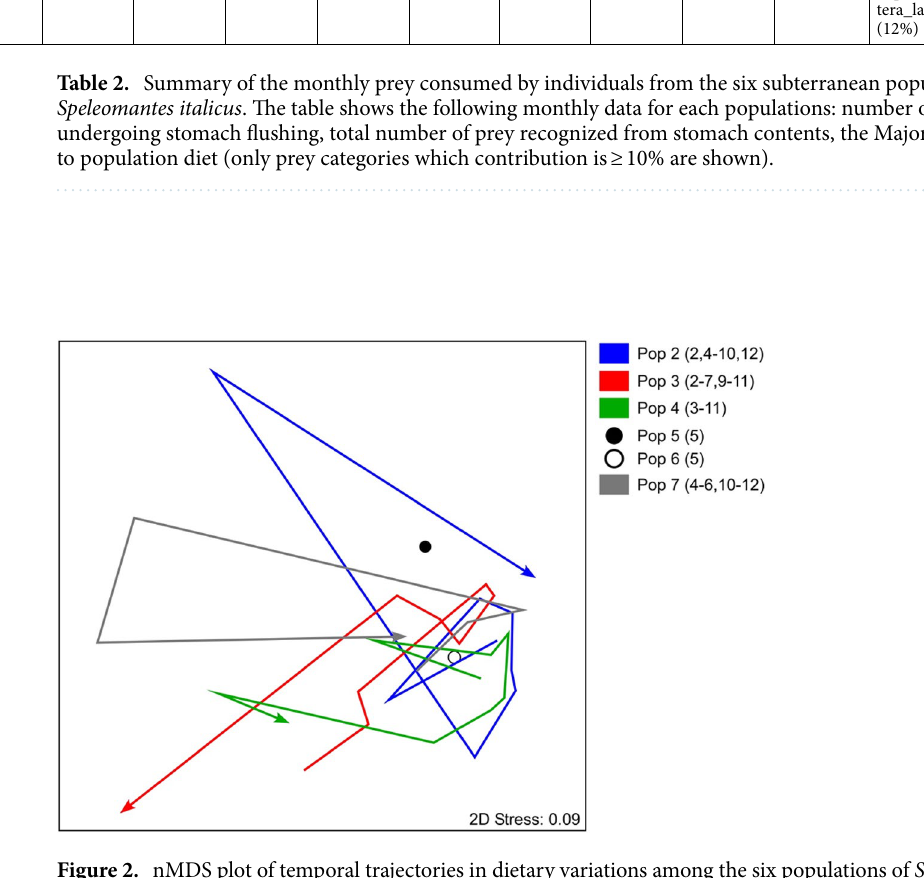
Figure 2. nMDS plot of temporal trajectories in dietary variations among the six populations of Speleomantes italicus under analysis; in the caption, the months when individuals were analysed are reported in